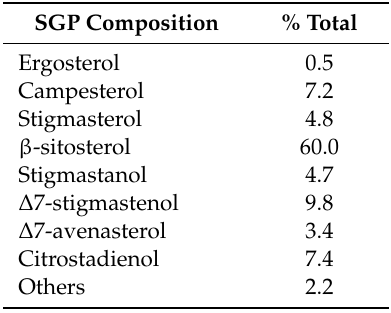
Table 2. Composition of soybean germ phytosterols extract